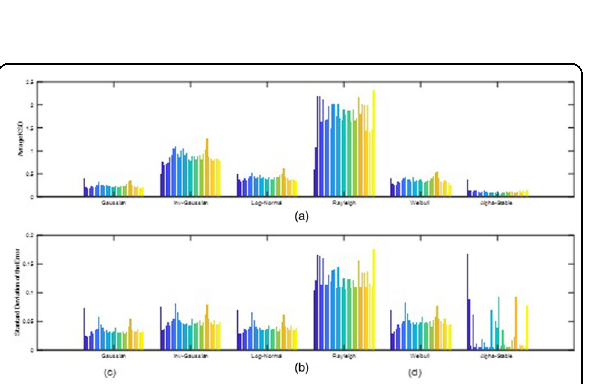
Fig. 17 Estimation results for Brodatz images. a Average KSD value for different distributions in each subband. b Standard deviation of the